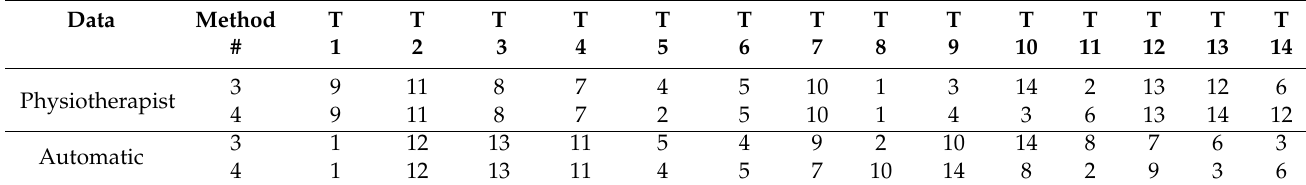
Table 5. E-BBS order of tasks using Methods 3 and 4. Task numbers are the standard BBS task numbers